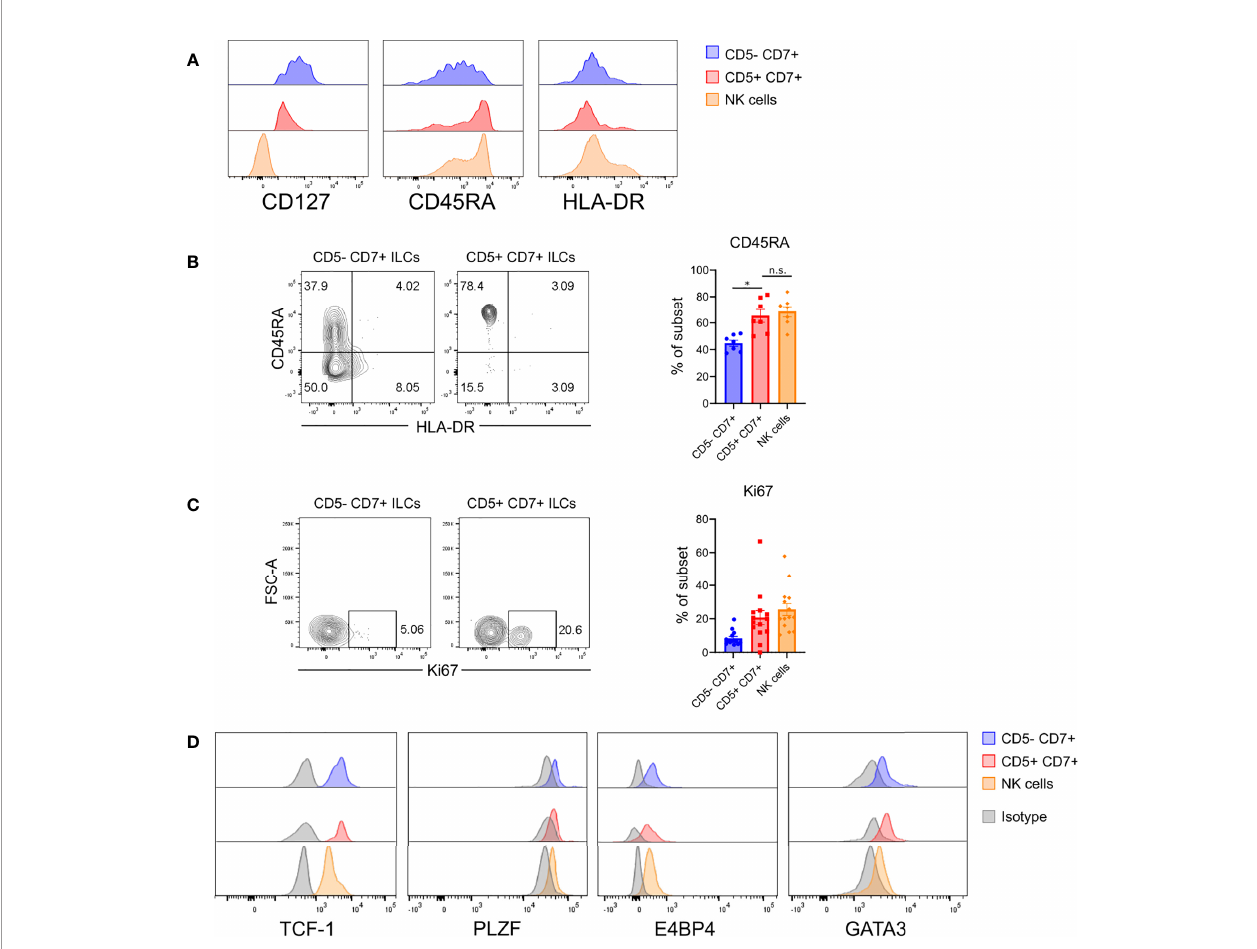
FIGURE 3 | Human CD5 + CD7 + ILCs have an immature surface phenotype and are actively dividing. (A) Surface expression of CD127, CD45RA, and HLA-DR on human CD5 - CD7 + ILCs, CD5 + CD7 + ILCs, and NK cells in the lung of HSPC-engrafted MISTRG mice. ILCs were gated as human CD45 + Lin - CD3 - TCR ab - CD94 - CD127 + cells and NK cells were gated as human CD45 + Lin - CD3 - TCR ab - CD94 + CD127 - cells as in Figure 1B . (B) Frequencies of CD45RA + cells among CD5 - CD7 + ILCs, CD5 + CD7 + ILCs, and NK cells from the lung of HSPC-engrafted MISTRG mice (n = 7). n.s., not signi fi cant; * P < 0.05 by one-way ANOVA, Tukey ’ s post-test. (C) Intracellular expression of the proliferation marker Ki67 in CD5 - CD7 + ILCs, CD5 + CD7 + ILCs, and NK cells from the lung of HSPC-engrafted MISTRG mice and frequencies of Ki67 + cells among each subset (n = 14). (D) Intracellular expression of transcription factors (TCF-1, PLZF, E4BP4, GATA3) in human CD5 - CD7 + ILCs, CD5 + CD7 + ILCs, and NK cells isolated from the spleen of HSPC-engrafted MISTRG mice. ILCs were gated as human CD45 + Lin - CD3 - TCR ab - CD127 + cells and NK cells were gated as human CD45 + Lin - CD3 - TCR ab - CD127 - CD56 + cells. Matched isotype antibodies were used as controls. Data represent mean ± SEM and are representative of at least two independent